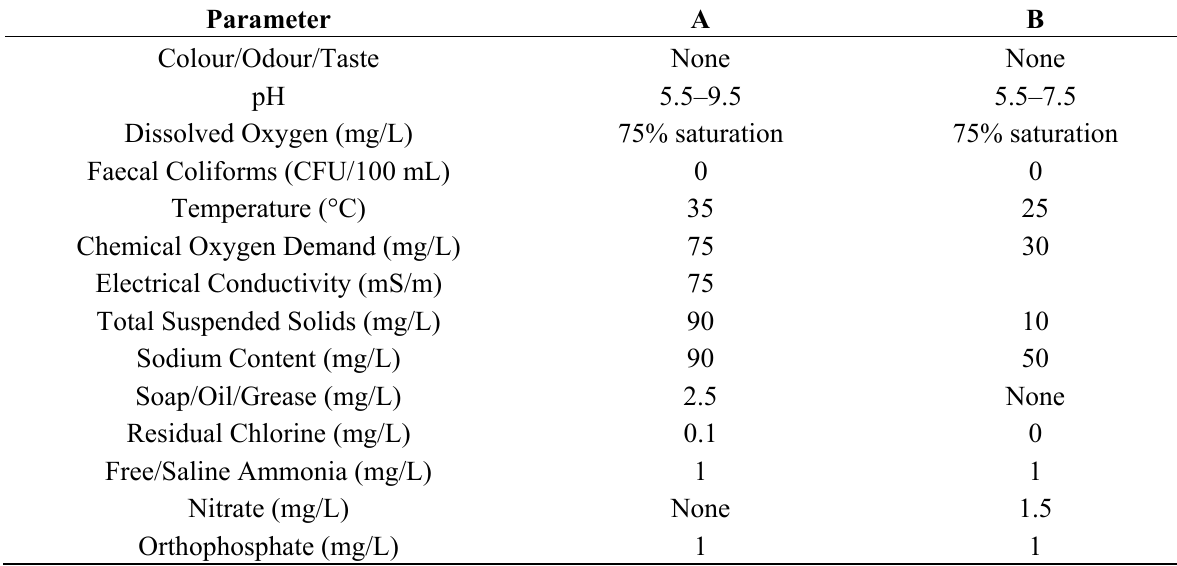
Table 4. Currently used guidelines by the eThekwini Municipality (South Africa) for treated effluent being discharged into a receiving